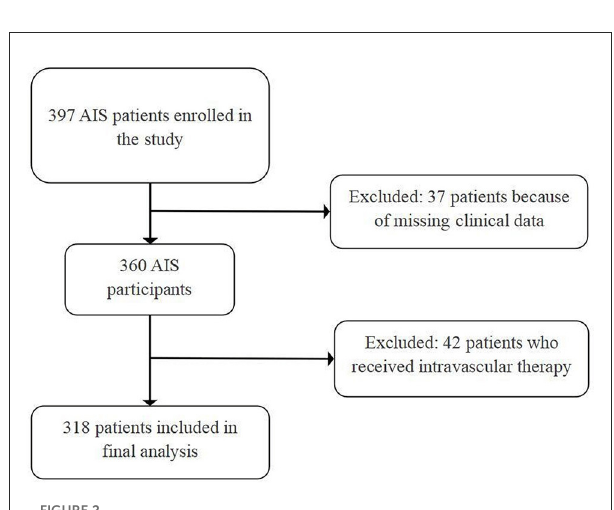
FIGURE2 Flow diagram of patient enrollment. AIS, acute ischemic stroke.